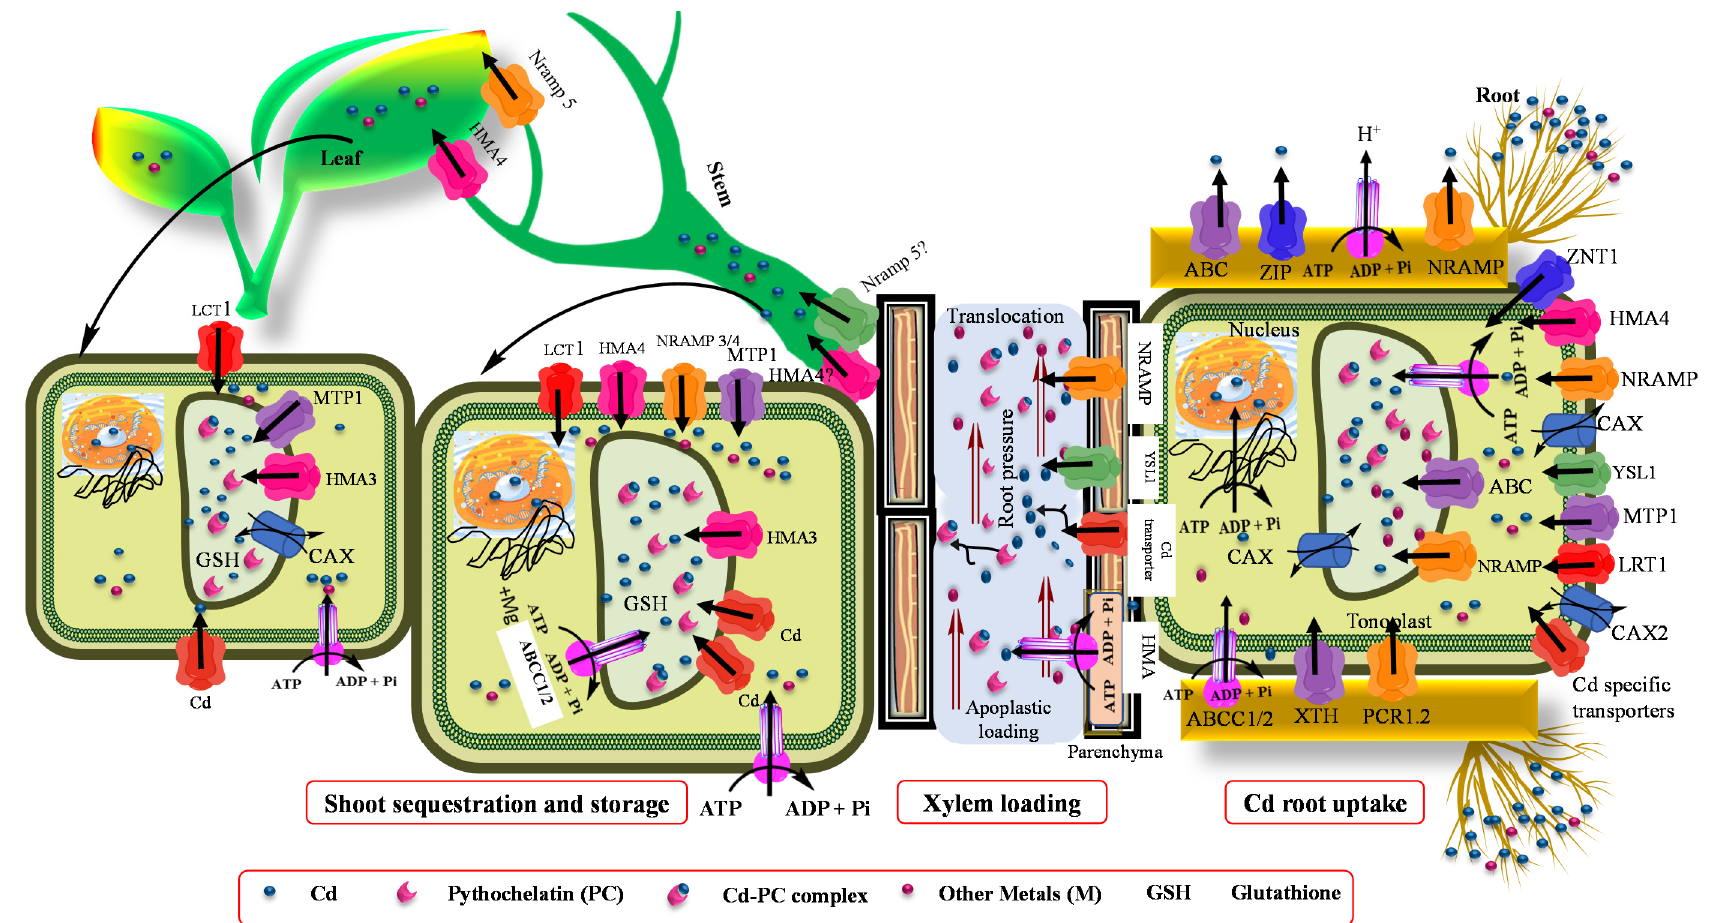
Figure 1. Depiction of major transporters present on the root, shoot, and leaves for Cd sequestration and storage (these processes are related to phytoremediation). Read text and Table 2 for more information.